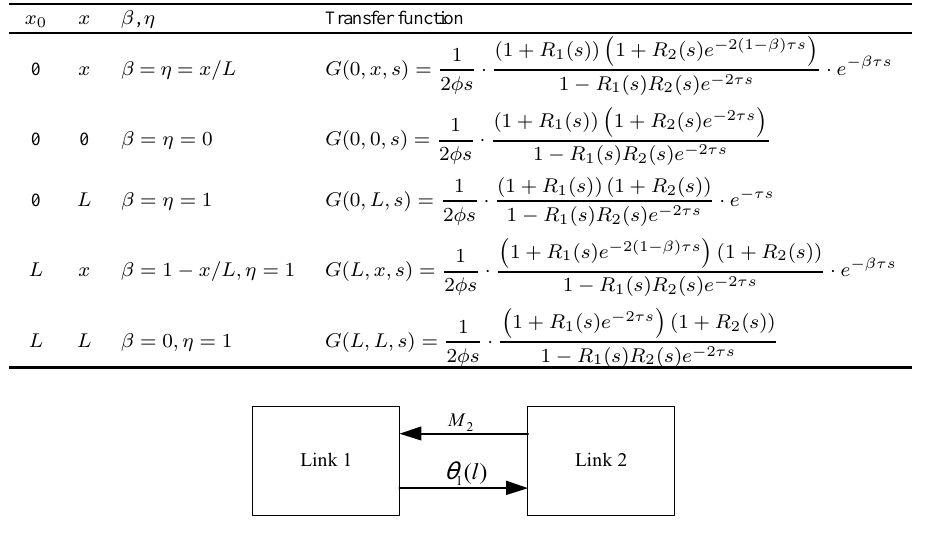
Table 1 Useful single link transfer functions